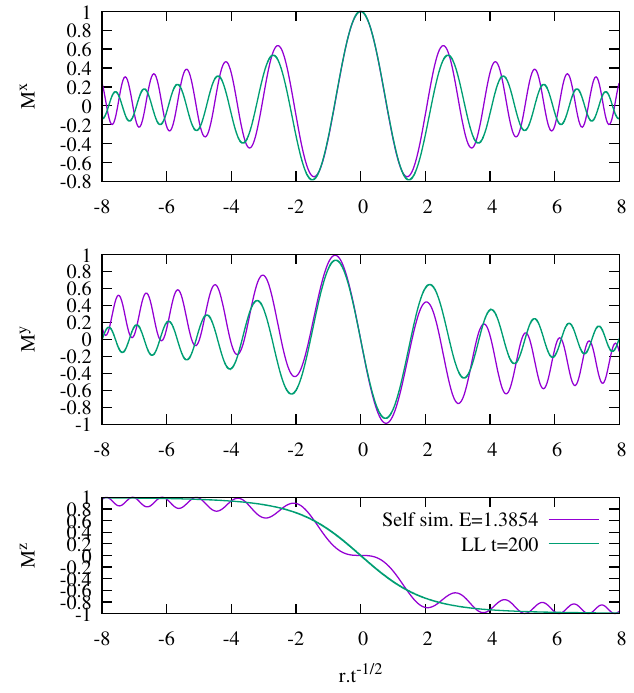
Self sim. E=1.3854 LL t=200